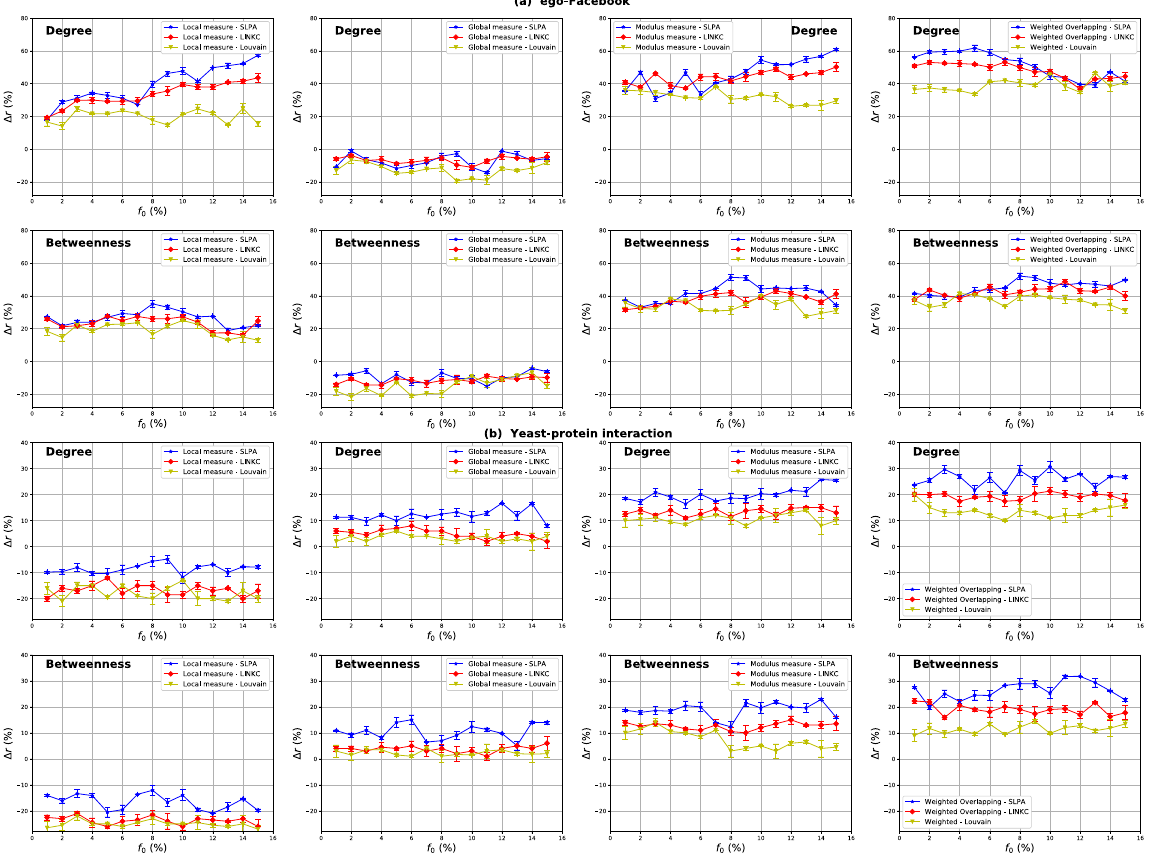
Figure 20. The relative difference of the outbreak size Δ r as a function of the fraction of initial spreaders f 0 . The Degree, Betweenness centrality measures derived from the Overlapping Modular centrality are compared to their standard counterparts. The measures are performed on ego-Facebook network in ( a ) and Yeast- protein interaction network in ( b ) for the SLPA, LINKC and Louvain algorithms.